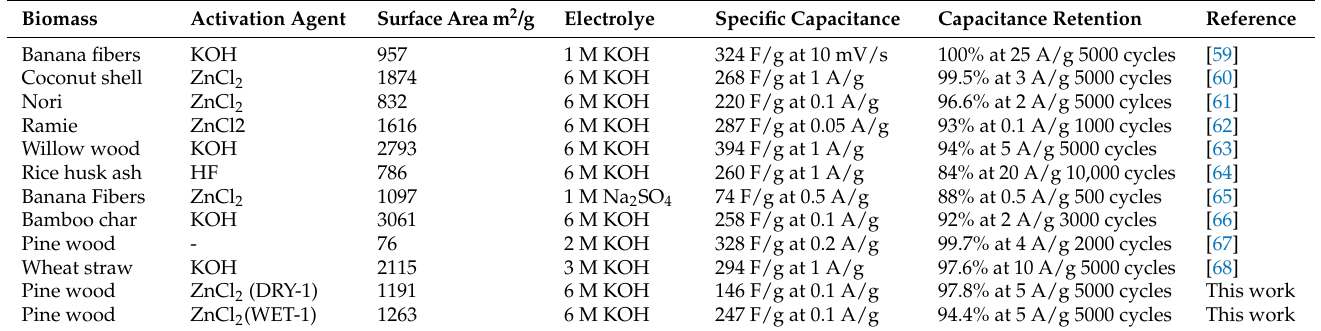
Table 3. Comparison of physicochemical properties of various biomass derived carbon